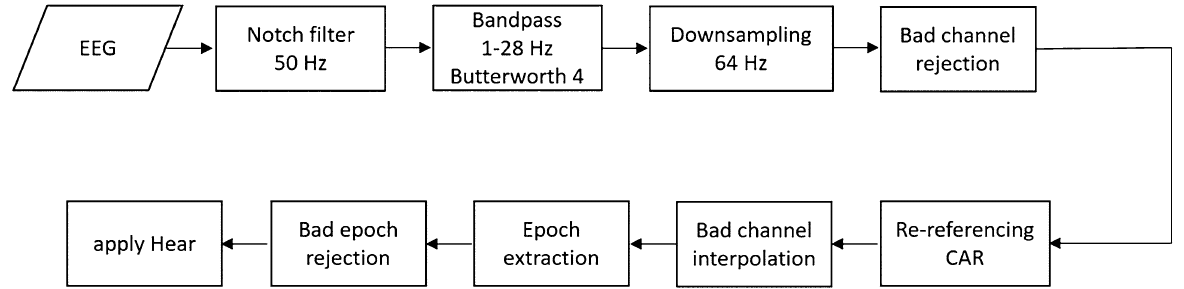
Figure 3. EEG preprocessing pipeline. Brain signals were band-stop (notch) and bandpass filtered, and bad channels were removed after downsampling. Then, data were re-referenced, followed by specific interpolation of removed channels. Next, noisy trials were rejected after extracting the epochs. The pipeline was the same for the online part, except for the ’Bad epoch rejection’